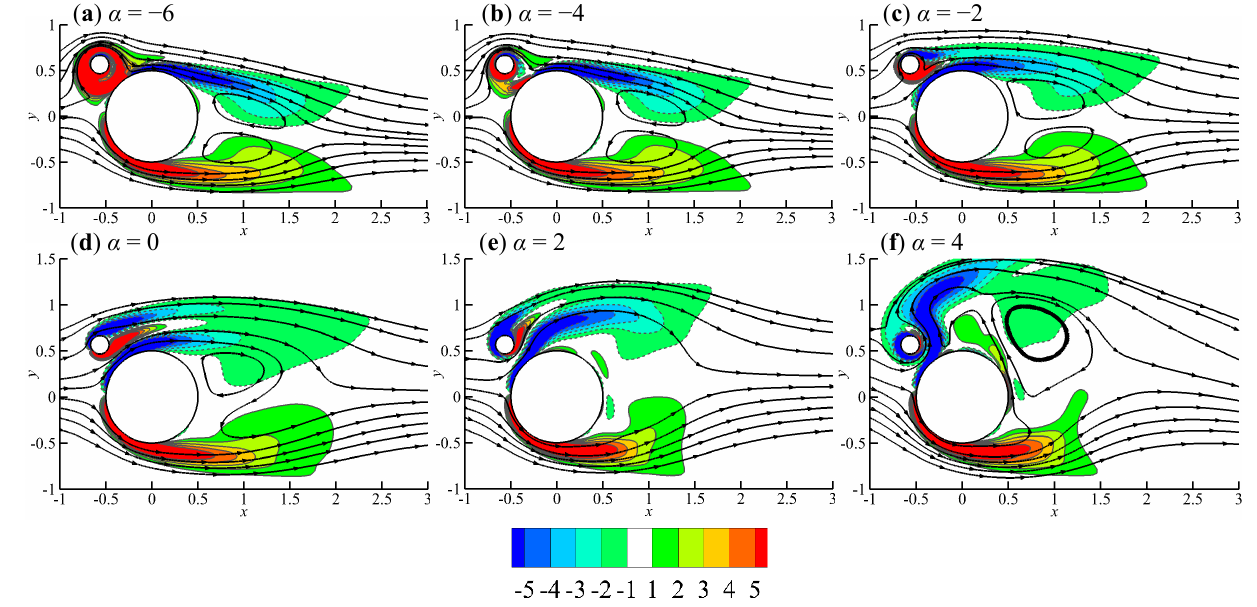
Figure 7. Streamlines and the contours of the nondimensional vorticity of the mean flow for β = 135 ◦ . The wake vortex shedding was mainly caused by the separated negative shear layers from the top of the cylinder and rod, and the positive shear layer from the bottom of the cylinder. For β = 45 ◦ , the negative shear layer from the top of the rod could be one that had separated from the cylinder previously and had reattached to the rod (Figure 5).